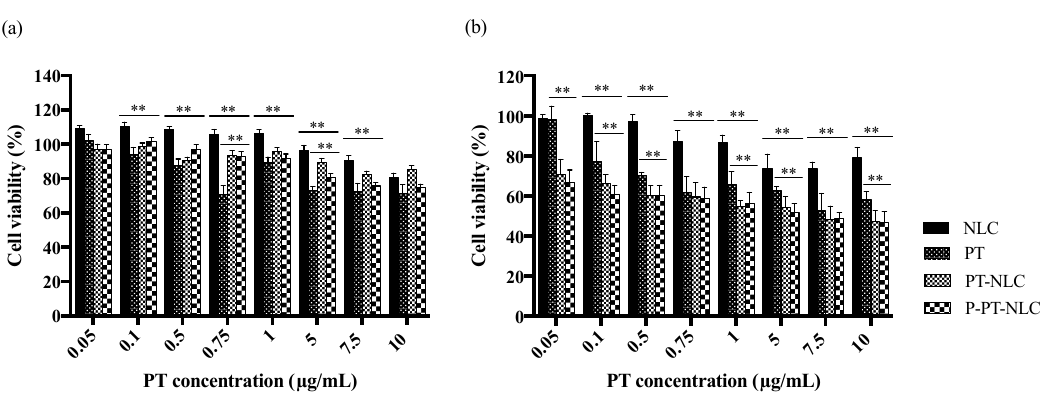
Figure 7. Cytotoxicity assay of PT, PT-NLC and P-PT-NLC in SK-OV-3 cells after 24 h ( a ) and 48 h ( b ). ** p < 0.01 (multiple t-tests).